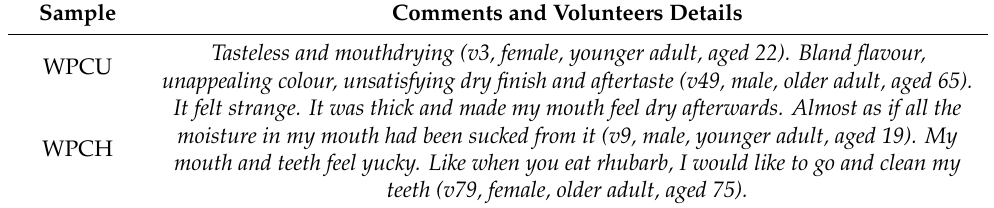
Table 6. Examples of volunteers whey protein beverage (WPB) comments (WPCU; unheated WPB and WPCH; heated WPB). Sample Comments and Volunteers